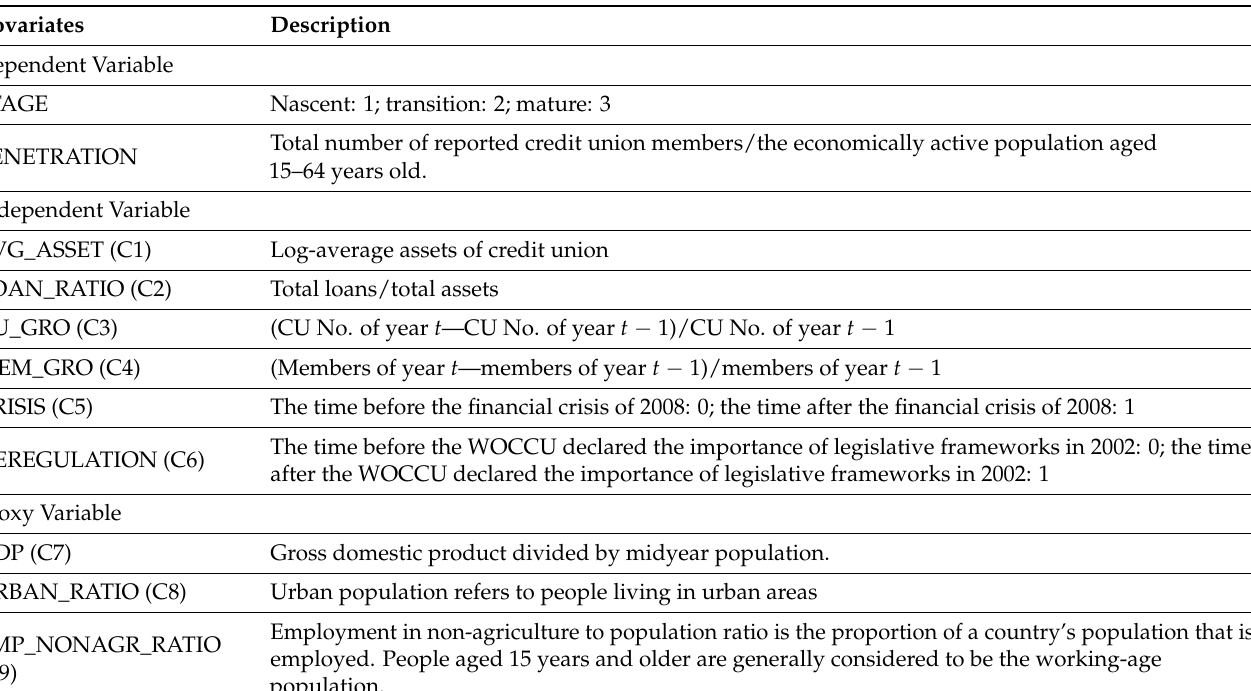
Table 3. Covariates of credit unions used in this research